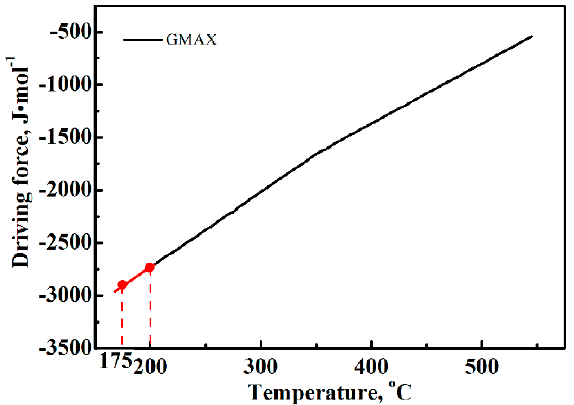
Figure 6. Estimated free energy difference according to the MUGG83 model. Note: GMAX is the maximum of free energy difference.